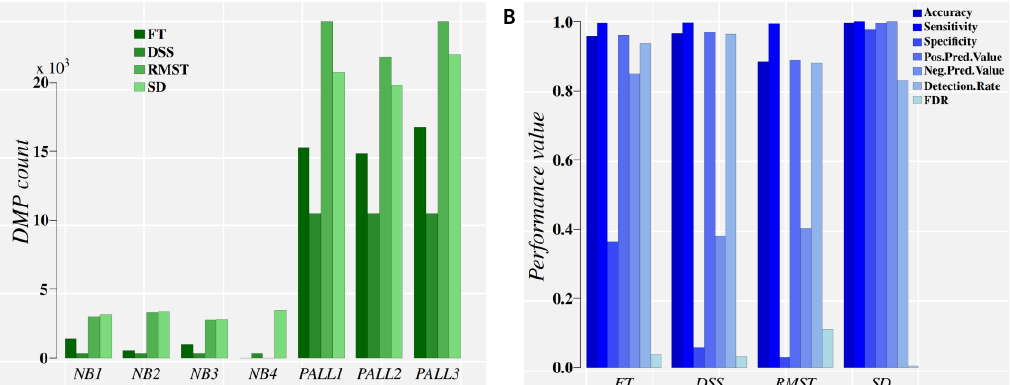
Figure 4. Direct comparison of classification performance for the control and treatment DMPs obtained on Chromosome 9 from the pediatric acute lymphoblastic leukemia (PALL) dataset by four methylation analysis approaches. Panel ( A ), DMP counts. Panel ( B ), classification performance evaluation. For a diseased individual, a diagnostic is based on the high classification performance obtained for hundreds of thousands of DMPs (when the whole methylome is analyzed) that are discriminated from methylation background variation found in the control population. NB1–NB4: Healthy individuals. PALL1-3: PALL patient individuals. FT: Fisher’s exact test, used by methylKit [15]. DSS: An R package that uses generalized linear regression and the Wald Test in the DMP identification [13]. RMST: Root-mean-square test, used by methylpy [16]. SD: Signal detection approach, implemented in